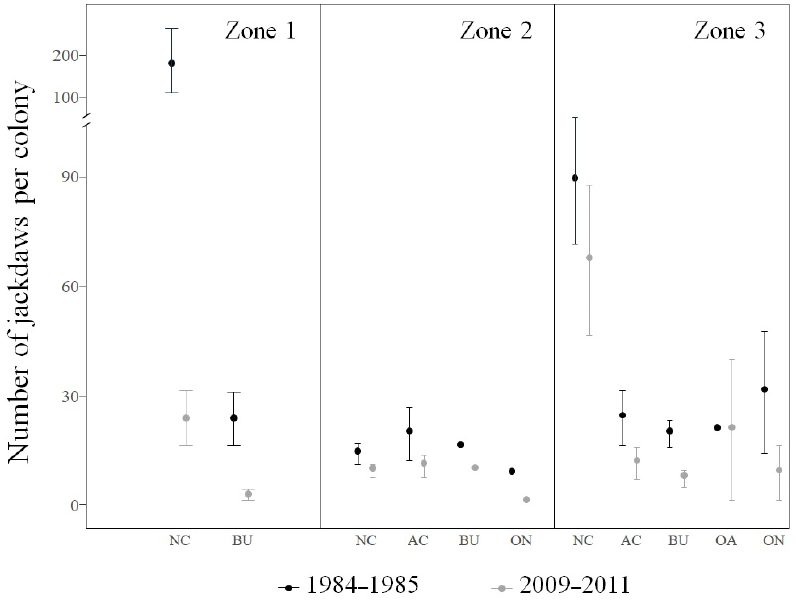
Figure 5. Number of breeding jackdaws per colony (mean ± SE) in 1984–1985 [61] and 2009–2011 (this study) in the three zones in which we subdivided the study region (see Figure 1). The substrate